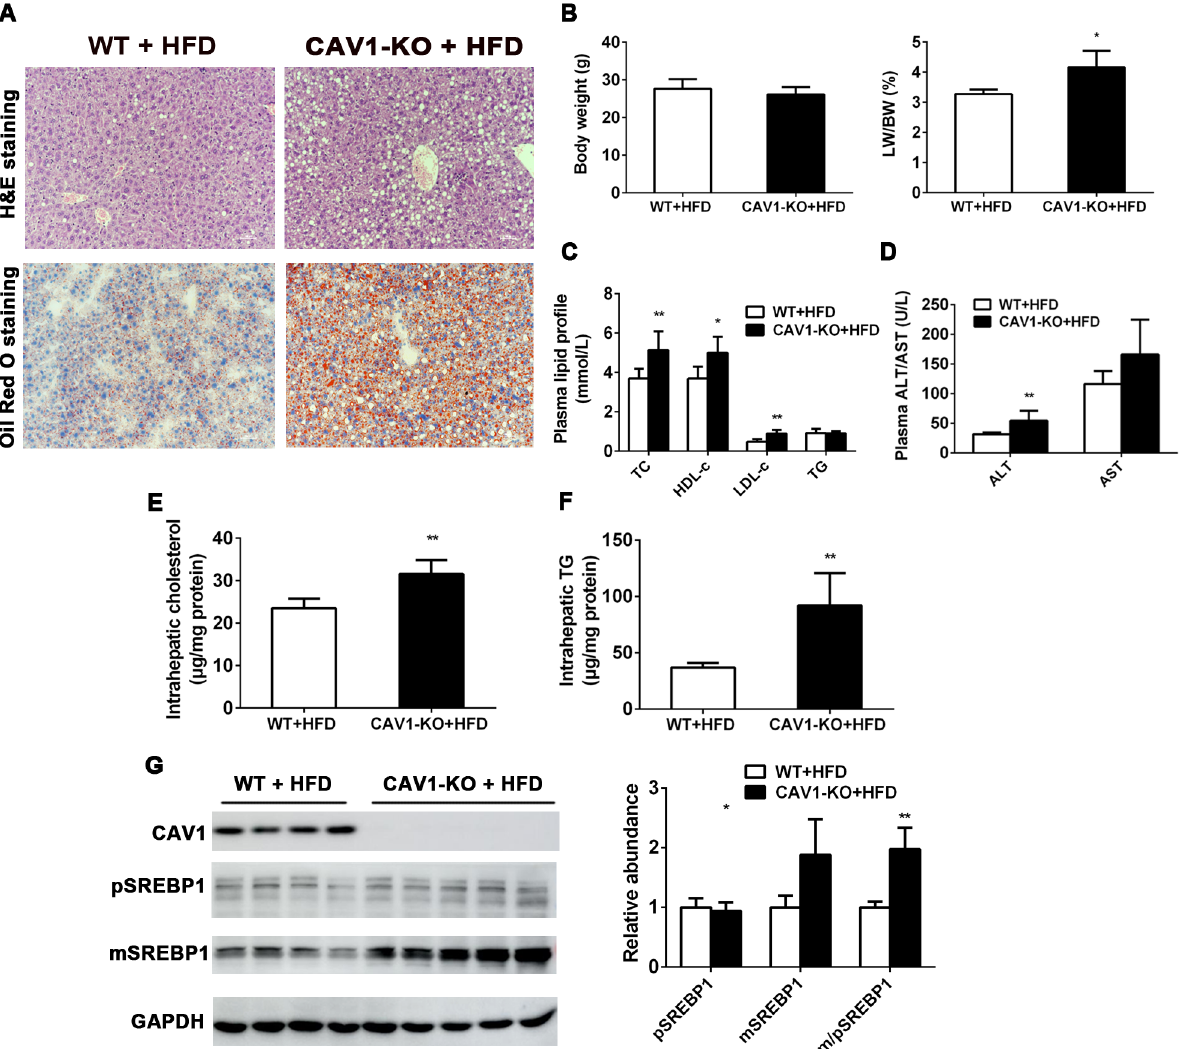
Fig 4. Genetic ablation of CAV1 aggravatesHFD-induced hepatic steatosis in mice. CAV1-KO mice andlittermate WT mice were fed with an HFD for 4 weeks. (A) Representative hematoxylin and eosin(H&E) stainingand Oil Red O stainingof sectionsfrom the livers of WT and CAV1-KO mice fed an HFD. (Originalmagnification × 400) (B) Comparison of the body weight(left) and the liver/bodyratio (right). (C) The plasmalevelsof total cholesterol (TC), HDL-c, LDL-c and TG in HFD-fedWT and CAV1-KO mice. (D) The plasmalevelsof ALT and AST in CAV1-KO mice and littermateWT mice weredetermined. (E) TC and (F) TG contents werequantifiedfrom wholelivers of HFD-fed WT and CAV1-KO mice. (G) The proteinexpression levelsof CAV1 and SREBP1were determined by western blot andquantifiedwith GAPDH as a loadingcontrol. pSREBP1and mSREBP1 denote the precursorandmature forms of SREBP1, respectively. Data are presentedas the mean ± SD. The CAV1-KO HFD-fedgroup ( n = 5) versus the WT HFD-fed group ( n = 6); * P < 0.05 and ** P < 0.01.